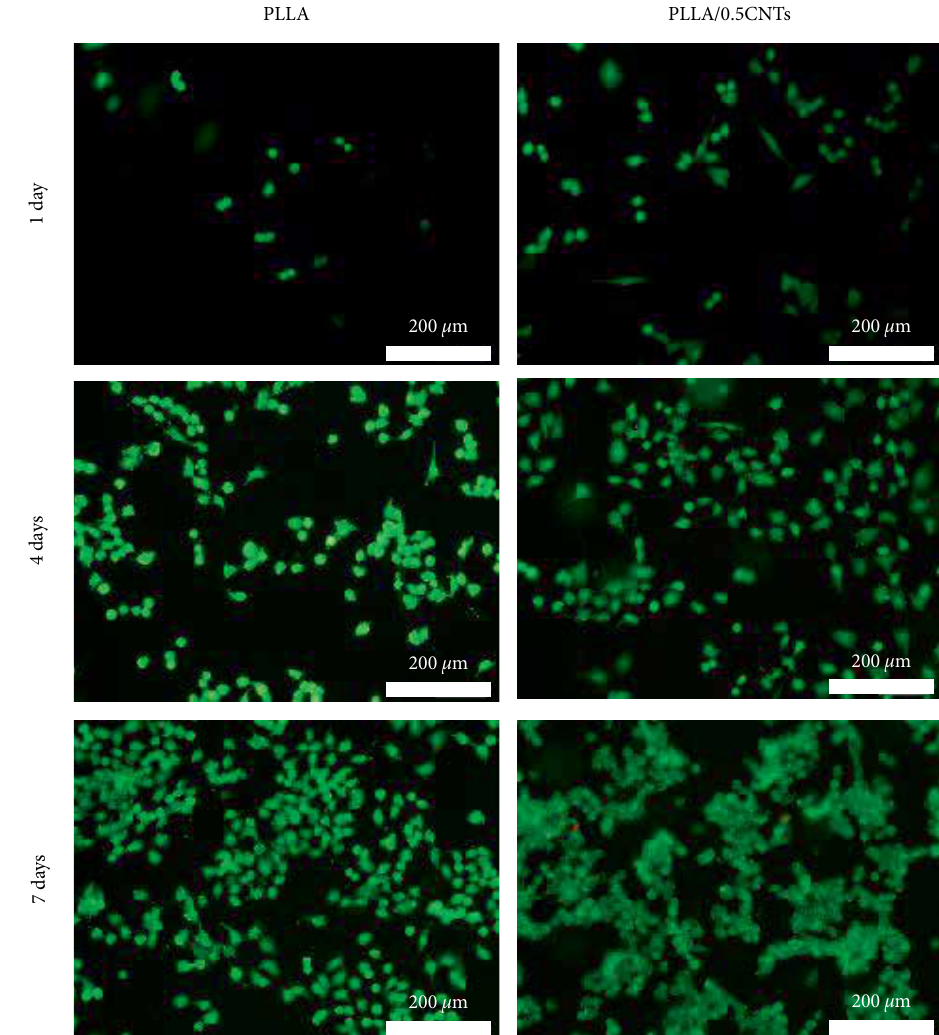
Figure 9: Representative fluorescence images of MG63 cells cultured on scaffolds for 1, 4 and 7 days.